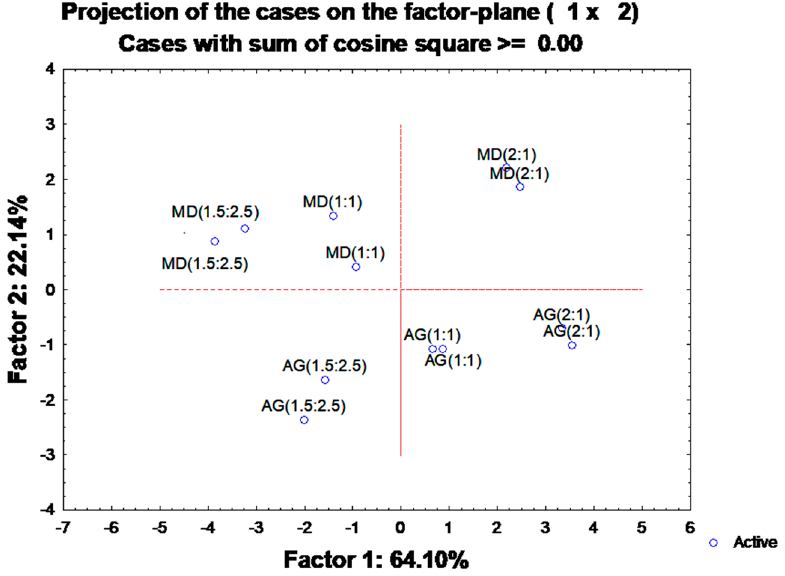
Figure 5. Principal component analysis with the grouping of accessions, according to maltodextrin (MD) or Arabic gum (AG) ratio (2:1, 1:1 and 1.5:2.5).